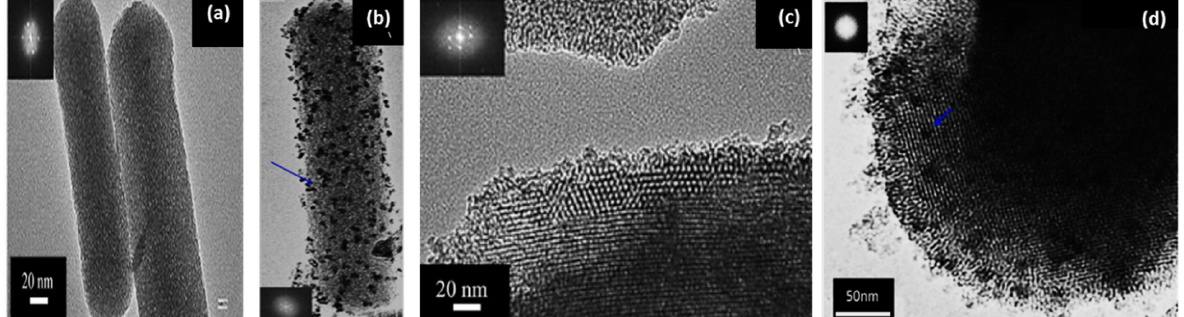
Figure 4. TEM of images: ( a ) mesoporous silica (rod shape), ( b ) mesoporous silica rod -Cu (NPs), ( c ) mesoporous silica (spherical shape), and ( d ) mesoporous silica spherical-Cu (NPs) and the insets show the electron diffraction pattern (Adapted with permission from Ref. [62]. Copyright 2018